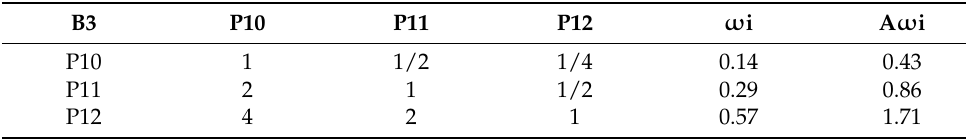
Table 9. B3-P comparison matrix.